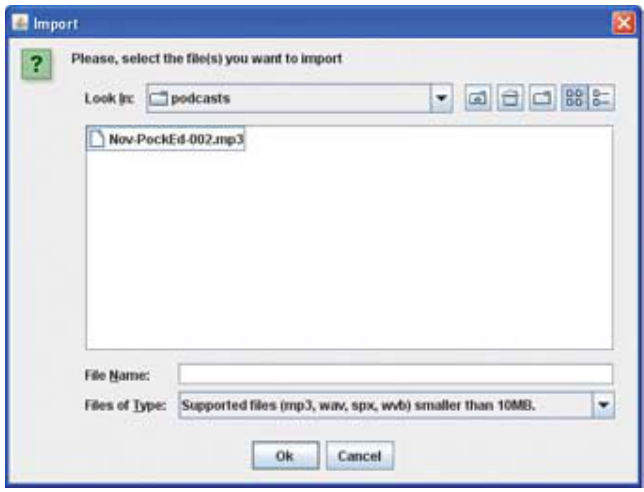
Figure 3. VB file upload screen. Students had to upload their listening tasks to the virtual staffroom VB, so that